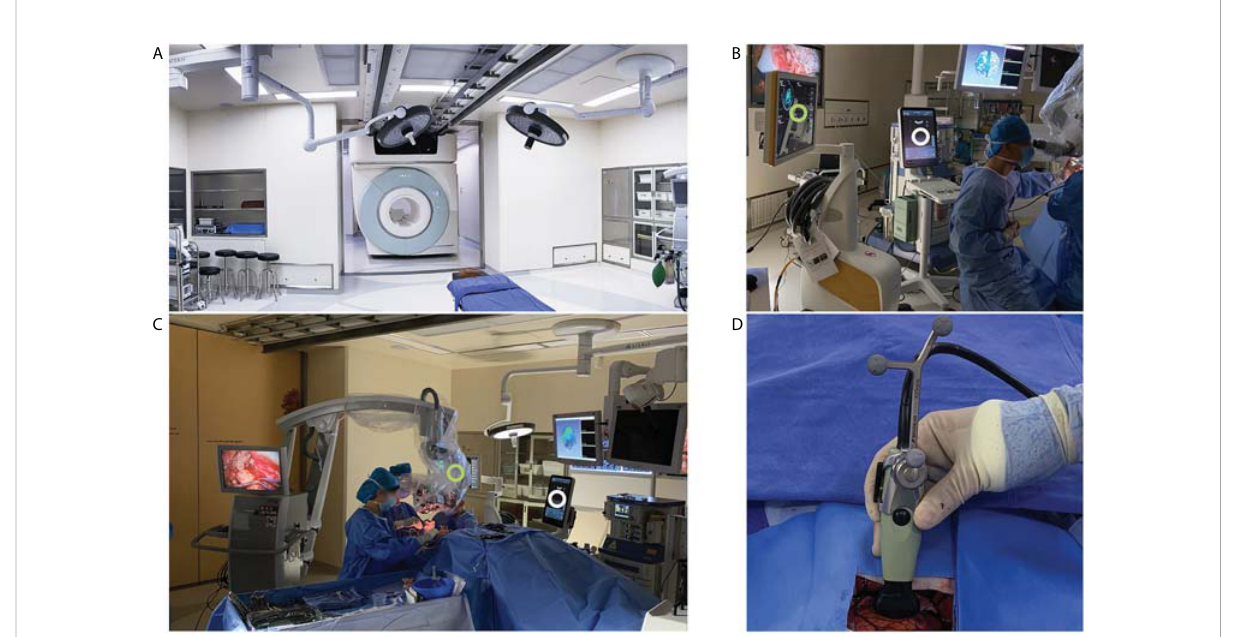
FIGURE 1 iMRI and iUS systems used in this study. (A) the iMRI system integrated a movable 3.0T MRI scanner. With the shielded door open, the scanner could move into the operating room to perform an iMRI scan. (B) iUS (white circle) and the navigation system (green circle) were registered during surgery to produce 3D iUS and co-planar MRI images. (C) During surgery, the shielded door was closed to isolate the magnetic fi eld. iUS (white circle) and navigation system (Green circle) were placed on the left side of the surgeon. (D) iUS was registered with the navigation system by attaching a rigid reference frame to the